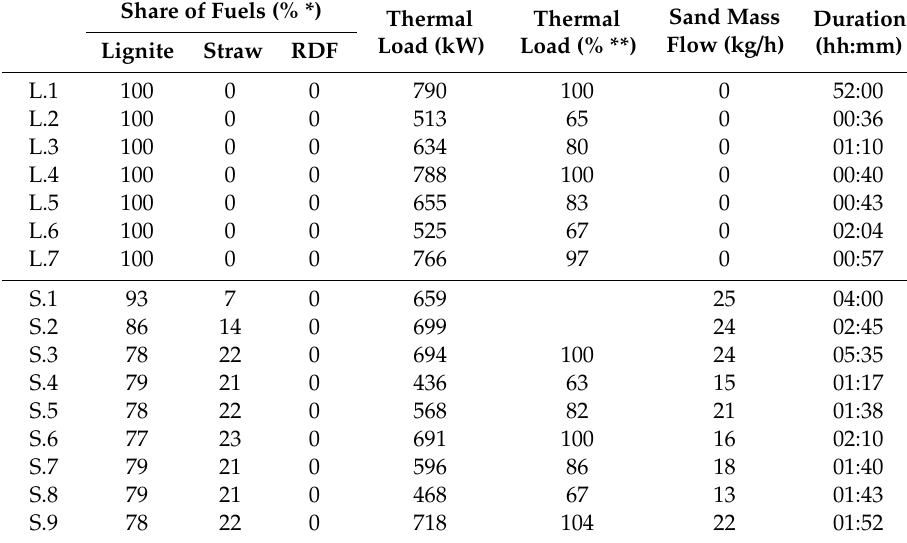
Table A1. Boundary conditions of test